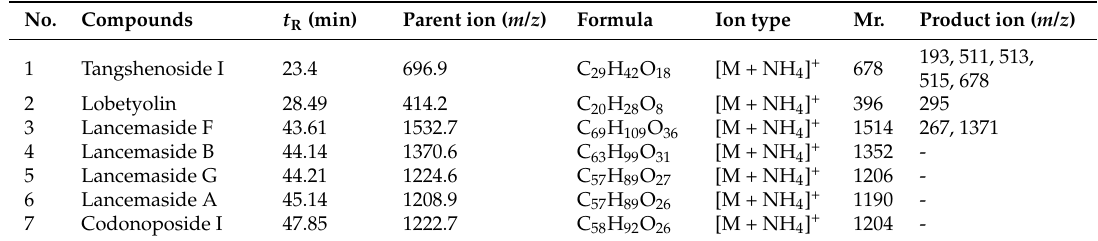
Table 2. Related substances of SCL identified by